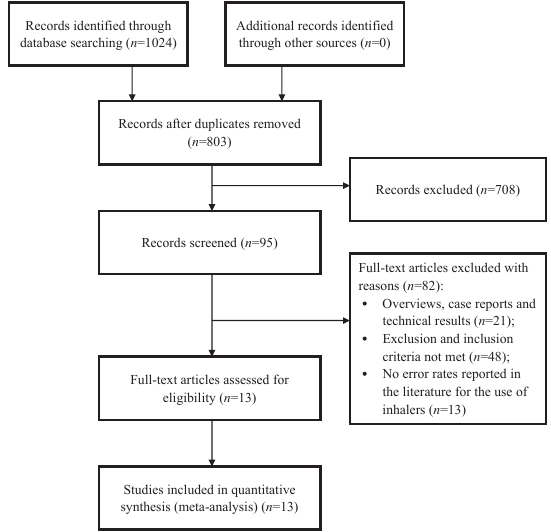
Figure 1. Literature search and